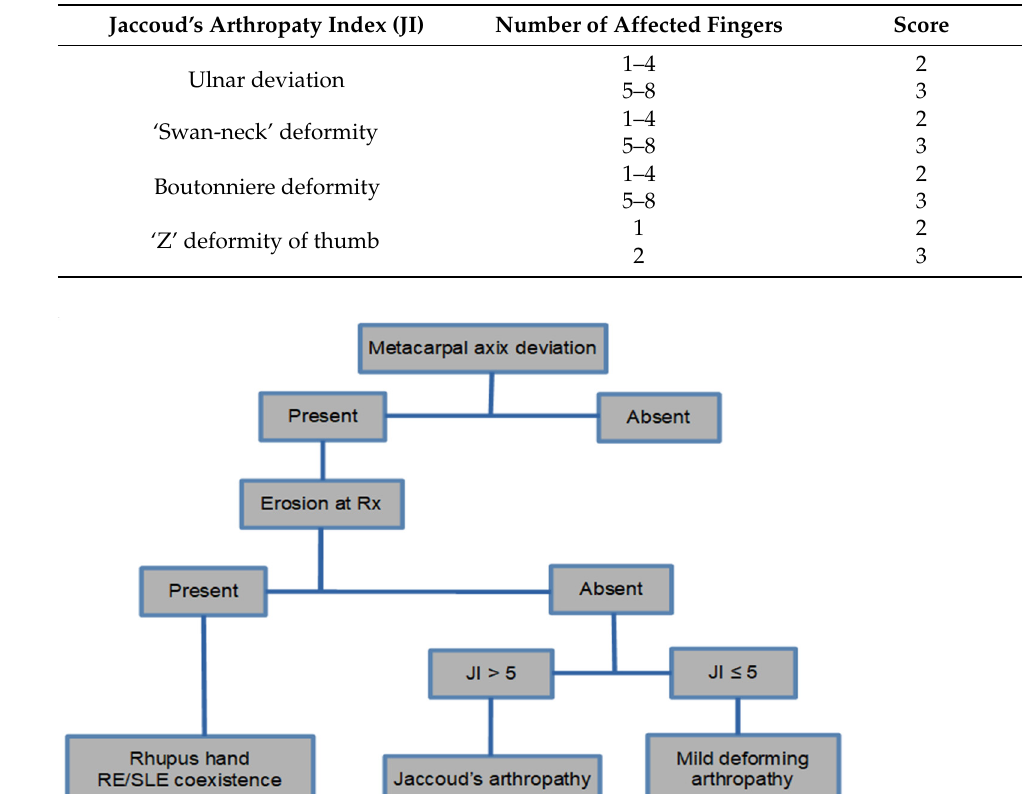
Table 1. Diagnostic criteria according to Spronk. Jaccoud’s arthropaty is considered present if the scoring (Jaccoud’s index; JI) achieved is >5 [6].